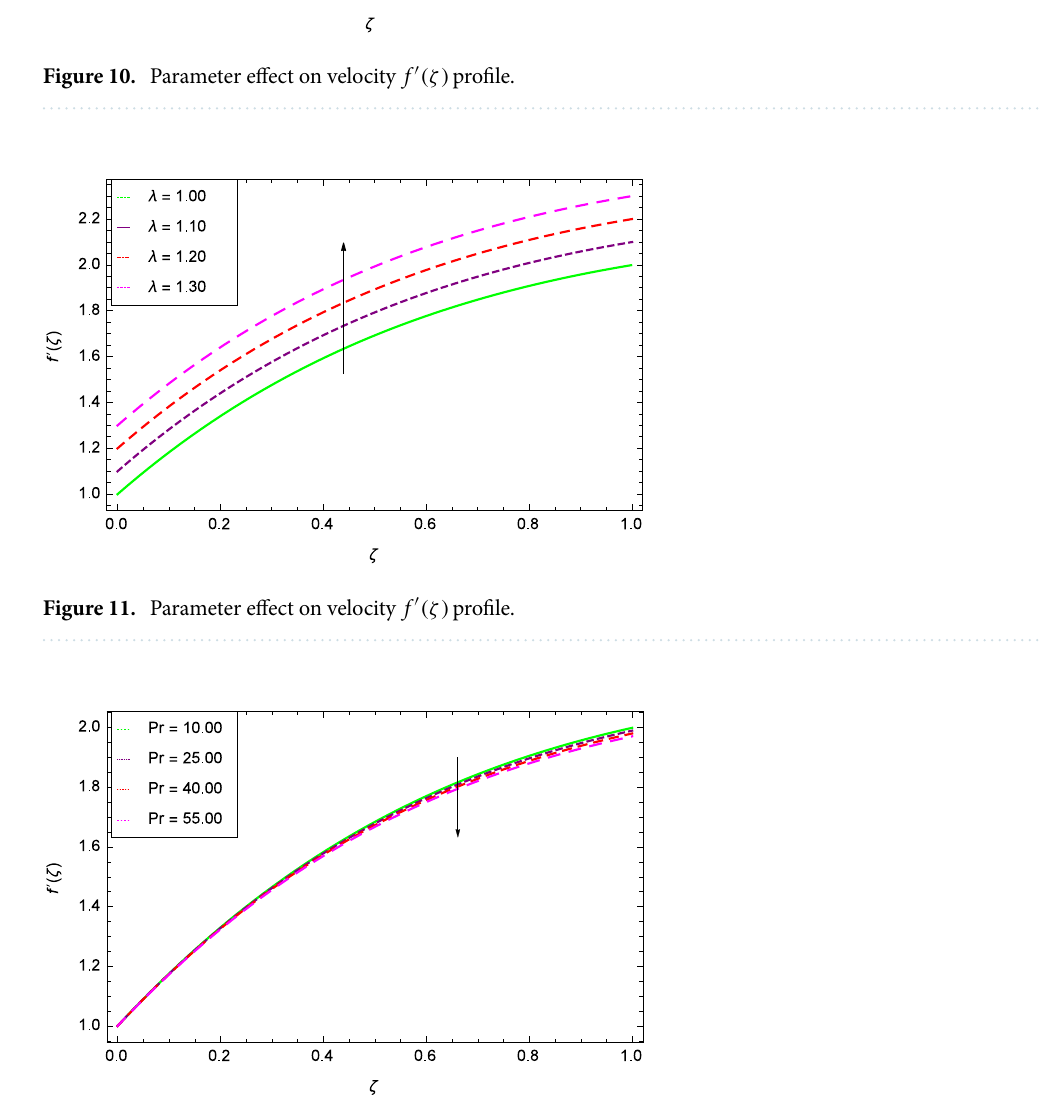
Figure 12. Parameter effect on velocity f ′ (ζ)